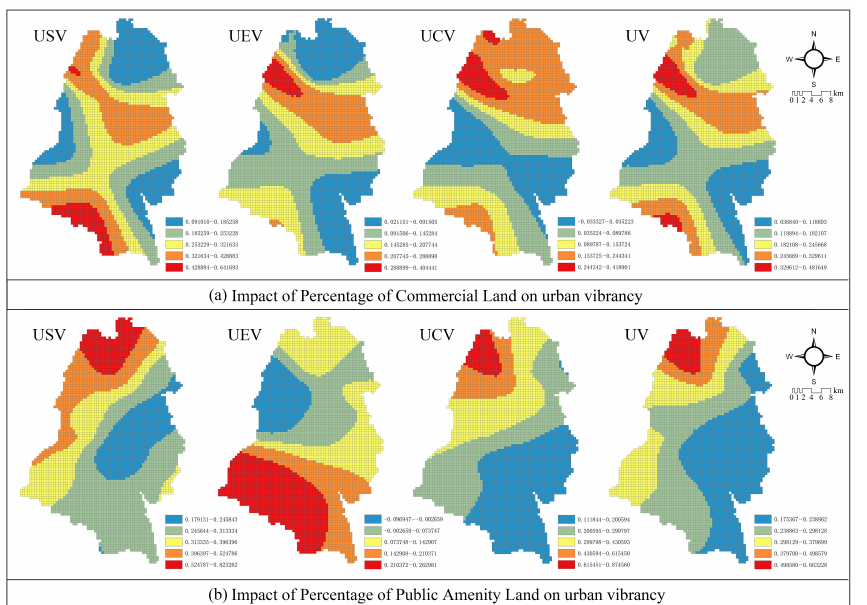
Figure 6. Impact of supporting infrastructure on various urban vibrancies. ( a ) Impact of Percentage of Commercial Land on Urban Vibrancy. ( b ) Impact of Percentage of Public Amenity Land on Urban